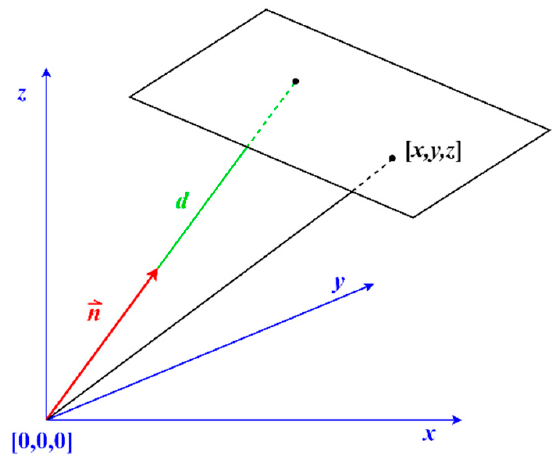
Figure 1. Mathematical model of the plane.